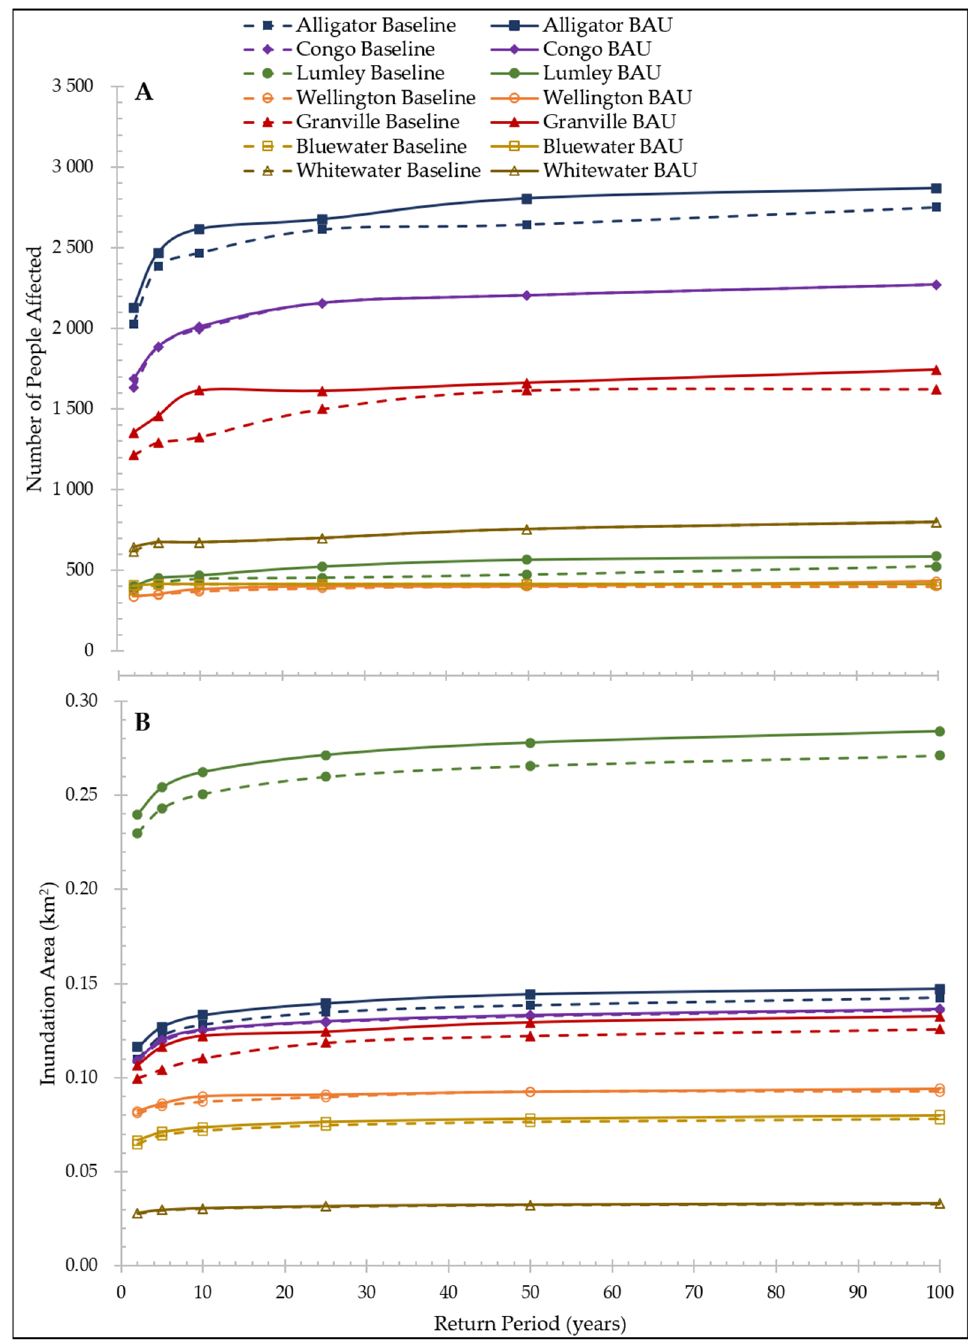
Figure 4. ( A ) Number of people affected by each return period storm for all seven urban rivers. ( B ) Inundation area from each return period storm for all seven urban rivers .